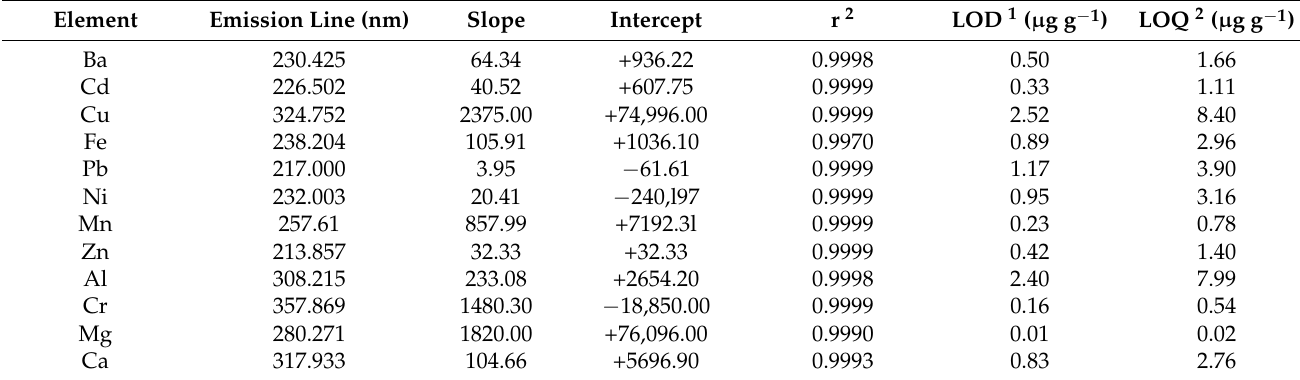
Table 1. Regression analysis, limits of detection (LOD) and limits of quantification (LOQs) of the inductively coupled plasma atomic emission spectrometry (ICP-AES) method.